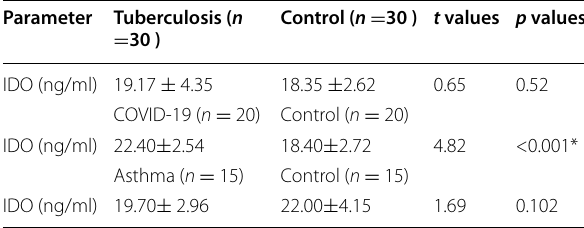
Table 1 The mean S. D of plasma IDO activities in Nigerian + patients with asthma, pulmonary tuberculosis, and COVID-19 compared with